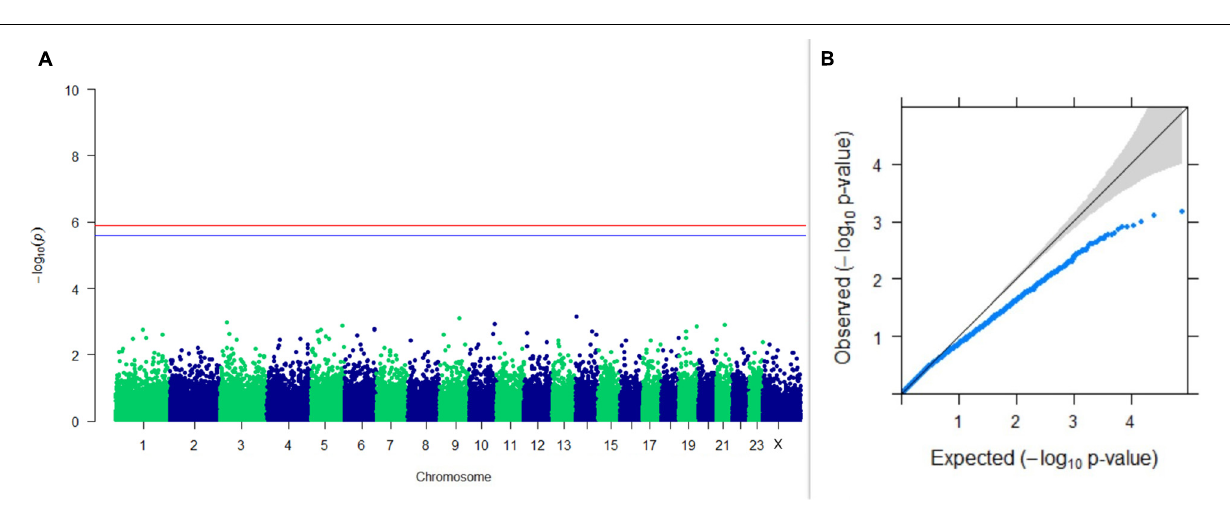
FIGURE 8 | Results of GWAS for lactation persistency based on Wood’s function as described by Macciotta et al. (2005). (A) Manhattan plot of genome-wide SNPs. The red line indicates the p- value threshold (expressed as –log 10 P ) corresponding to FDR-corrected p- values or q = 0.05, above which the SNPs are considered to be significantly associated with the trait, while the blue line indicates the genome-wide suggestive threshold at q = 0.1. The SNPs identified on chromosome no. 24 were screened out from analysis because of stringent quality control; hence, it is not represented in the Manhattan plot. (B) Q-Q plot of the p-